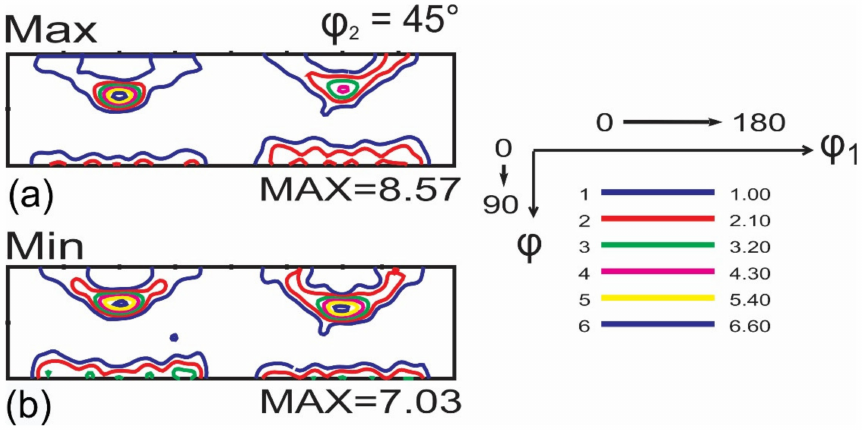
Figure 8. ϕ 2 = 45 ◦ ODF section of ( a ) max and ( b ) min sides of the drawn tube using − 5 ◦ tilting angle.